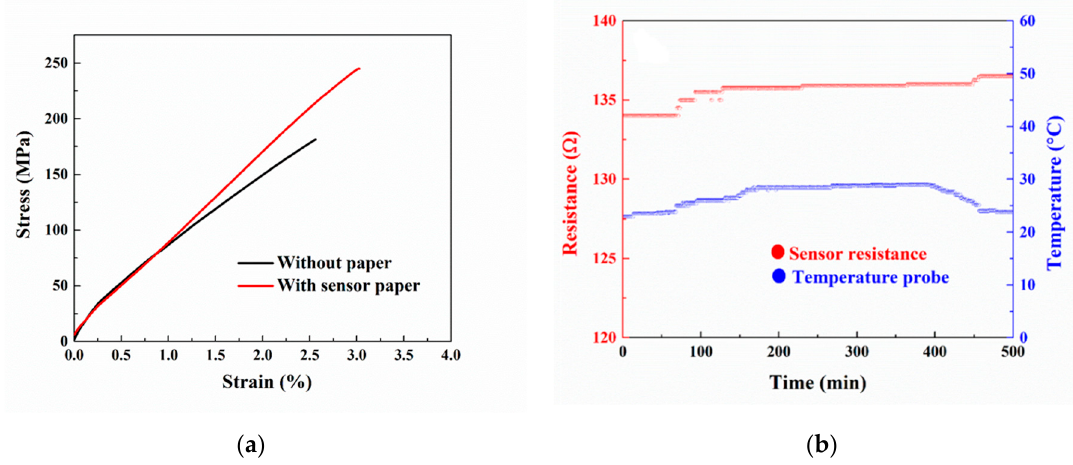
Figure 6. ( a ) Tensile stress-strain curves of epoxy-natural fiber composite integrated with and without paper; ( b ) response of two sensors during the vacuum infusion process of epoxy-natural fiber composite.